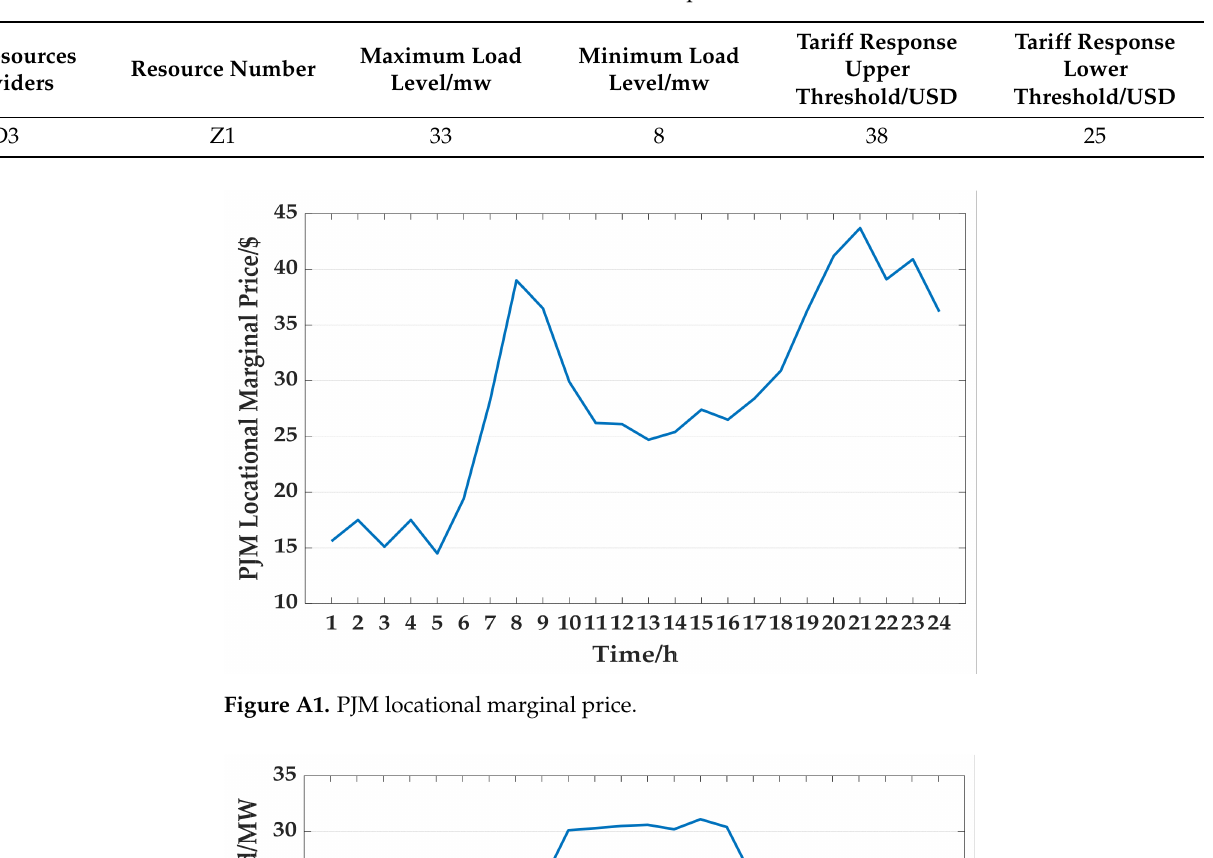
Table A5. PDR resource characteristic parameter.